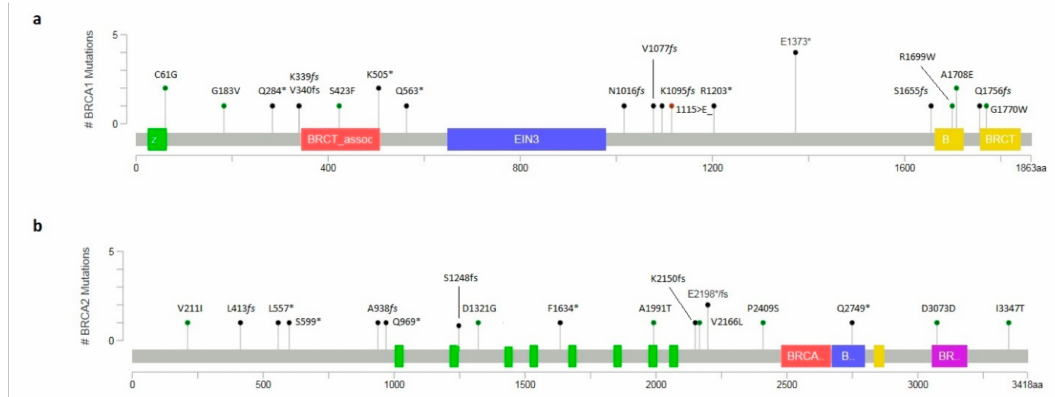
Figure 2. Lollipop plot by MutationMapper reporting all BRCA1 / 2 small variants a ff ecting coding region. ( a ) BRCA1 variants distribution. The c.4117G > T; p.(Glu1373Ter) resulted as the most frequent among detected variants. ( b ) BRCA2 variants distribution. Two di ff erent variants a ff ected the same codon: the p.(Glu2198Ter) and p.(Glu2198AsnfsTer4). Diagram circles are colored with respect to the corresponding variant types. Variant types and corresponding colors are as follows: green for missense and synonymous variants, black for truncating mutations (nonsense and frameshift), brown for in-frame deletions and insertions. *: Stop